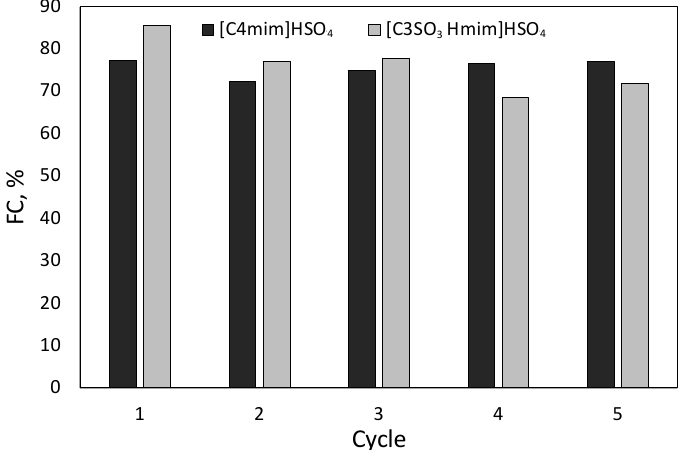
Figure 5. Molar conversion into furfural determined for 5 consecutive reaction cycles using [C4mim]HSO 4 or [C3SO 3 Hmim]HSO 4 .